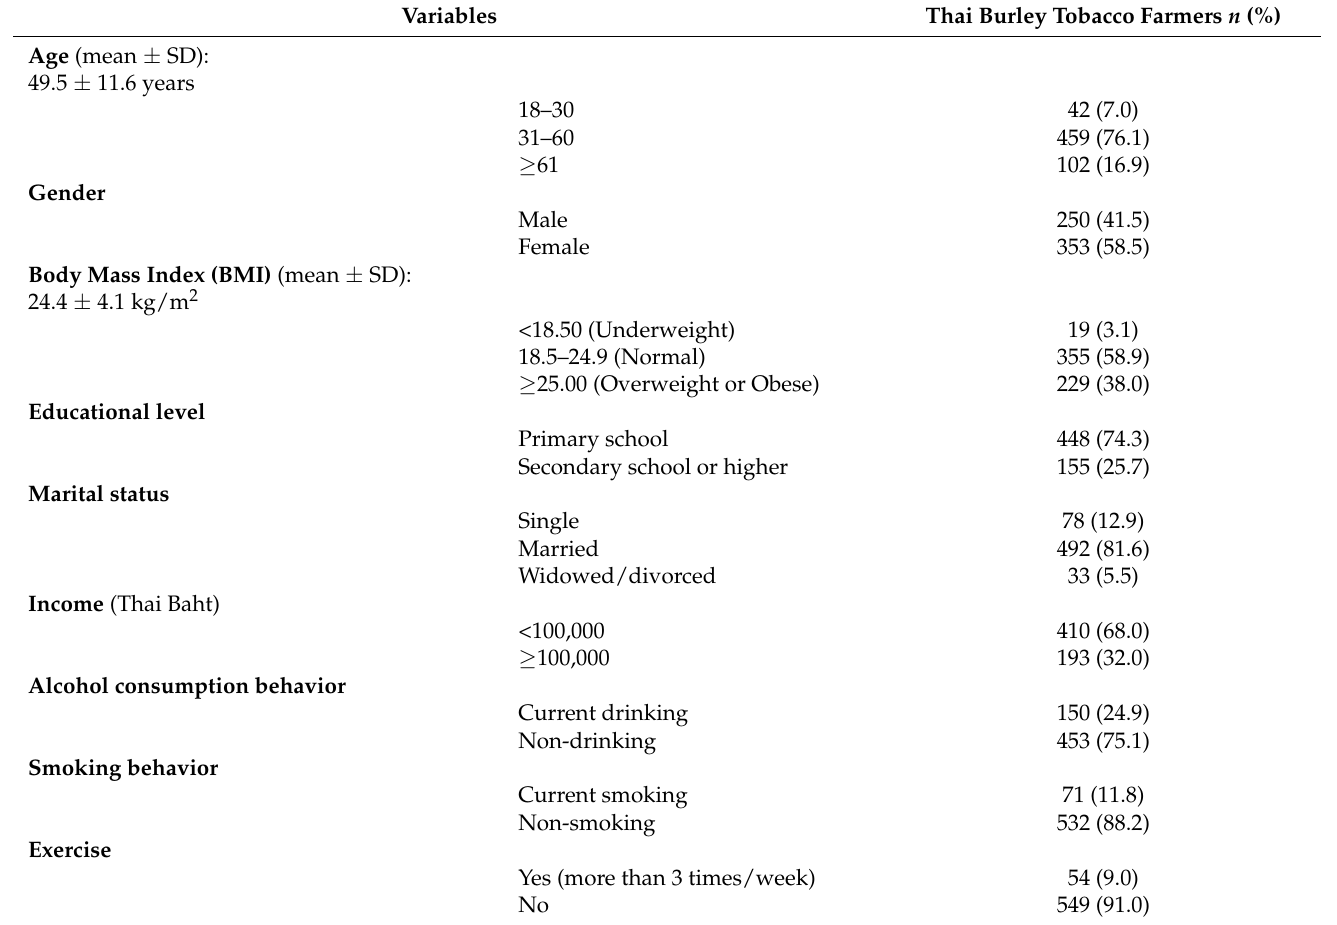
Table 1. Demographic characteristics of Thai Burley tobacco farmers ( n =